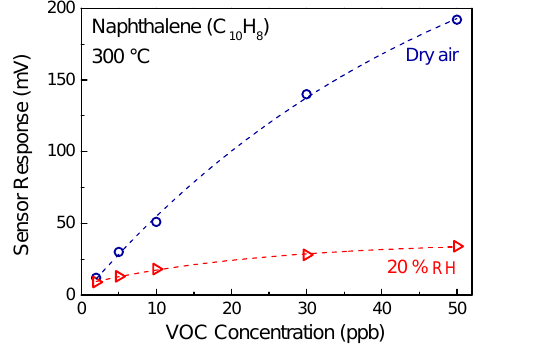
Figure 5. Effect of relative humidity on the sensor response to naphthalene (C 10 H 8 ) from 50 to 2ppb at 300 ◦